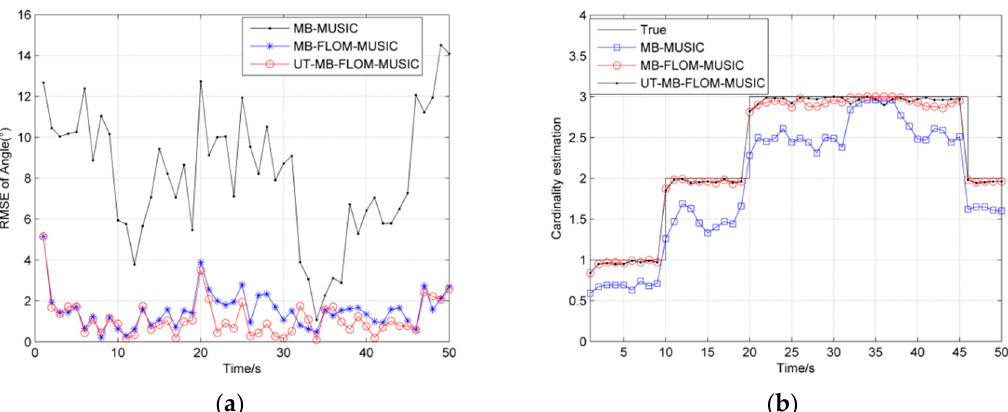
Figure 4. RMSE and cardinality error of angle under different α , L = 100, MC = 100 and GSNR = 10 dB: ( a ) The RMSE under different α ; ( b ) cardinality error under different α .